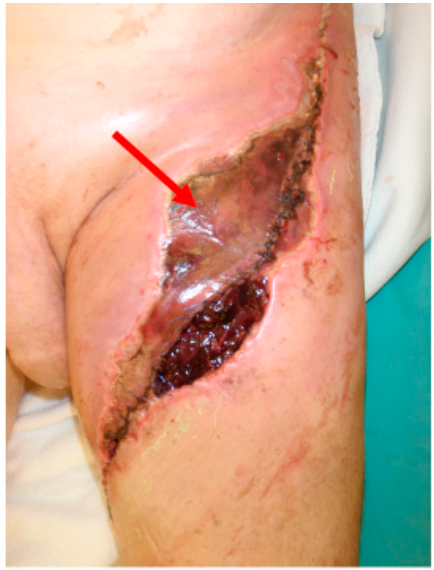
Figure 1. Clinical case of a patient treated with neoadjuvant radiotherapy in extremity soft tissue sarcoma. Wound necrosis (red arrow) was observed in the radiated